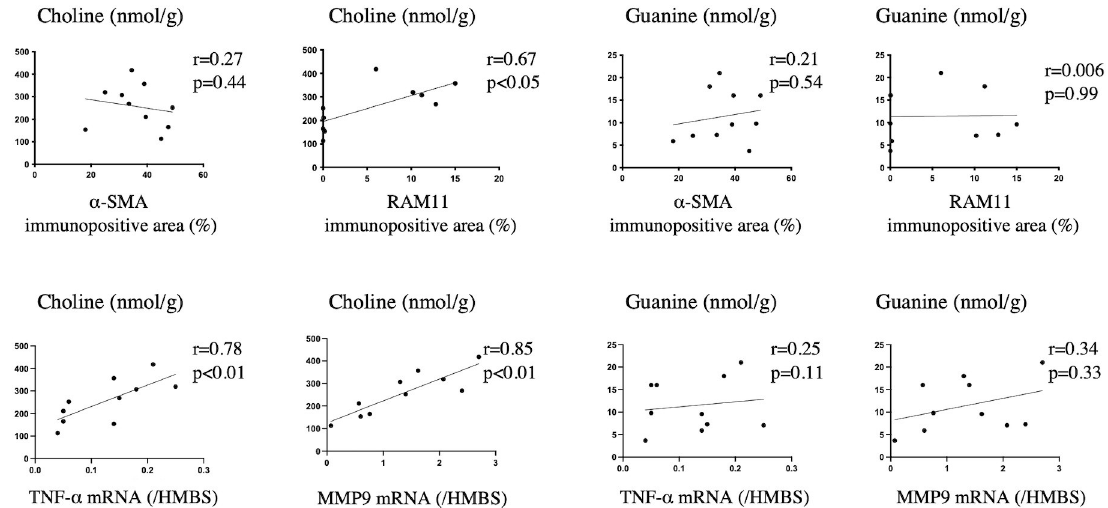
Fig 4. Correlation of arterial choline and guanine levels with vascular components. Correlation of arterial choline and guanine levels with α -SMA- and RAM11- immunopositive areas and TNF- α and MMP9 mRNA levels (n = 10 each; Spearman’s test).